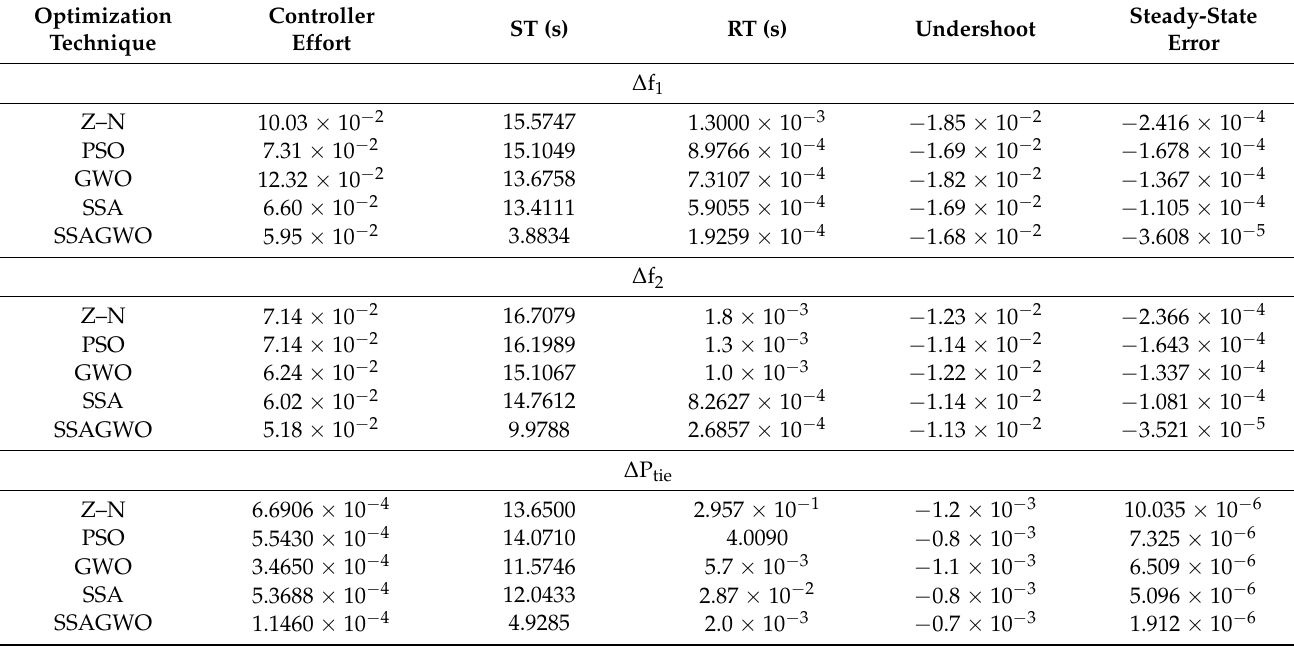
Table 4. Frequency and power deviation in the tie-line power of case I.